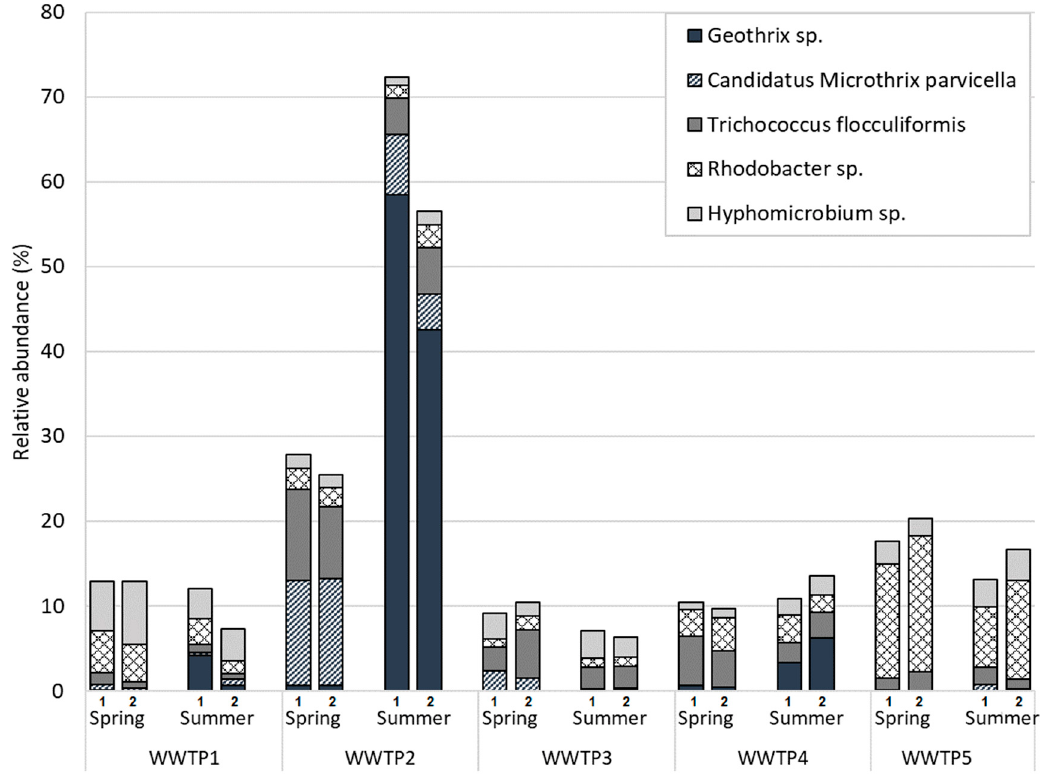
Figure 3. Relative abundance of the dominant genera in activated sludge of Finnish wastewater treatment plants (WWTPs) during the spring and summer season.